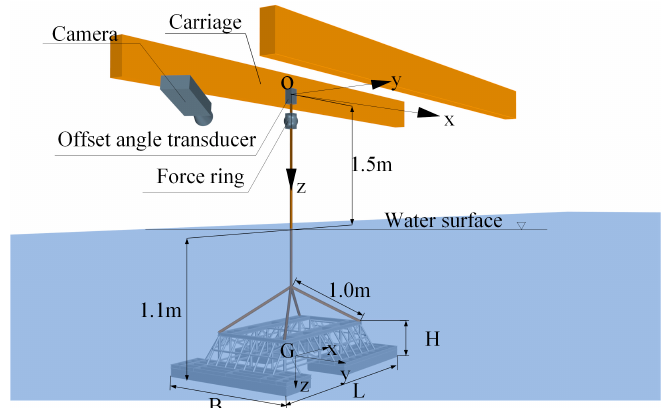
Figure 3. Arrangement of experimental equipment.